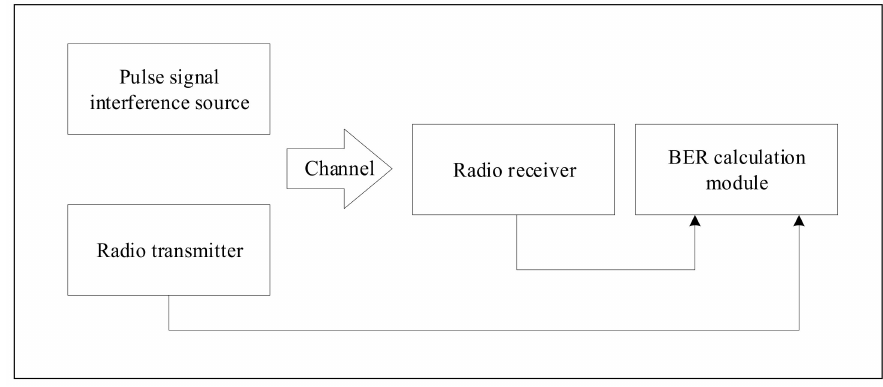
Figure 7. Block diagram of the system model.